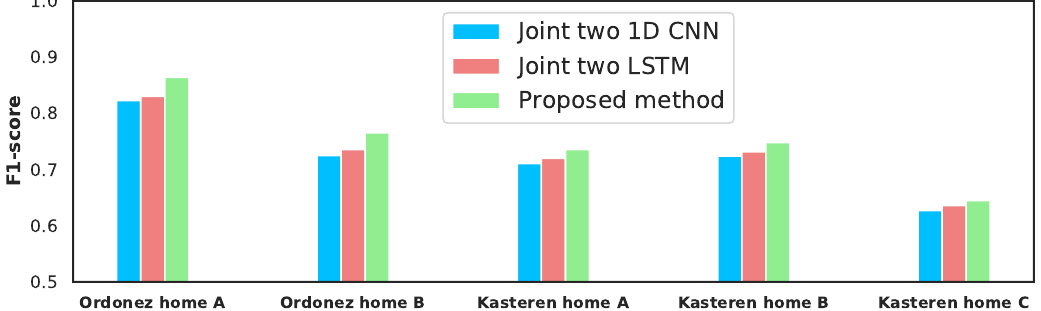
Figure 9. Joint learning compared with joint LSTM+LSTM and Joint 1D CNN+1D